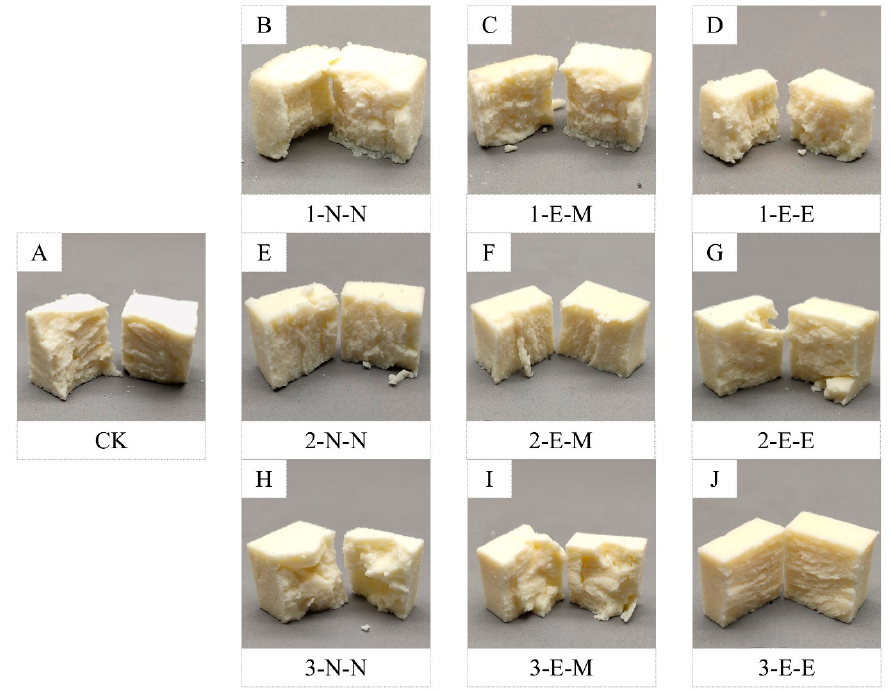
Figure 2. Photos of the surface and cross-section of freeze–thawed Mongolian cheeses.